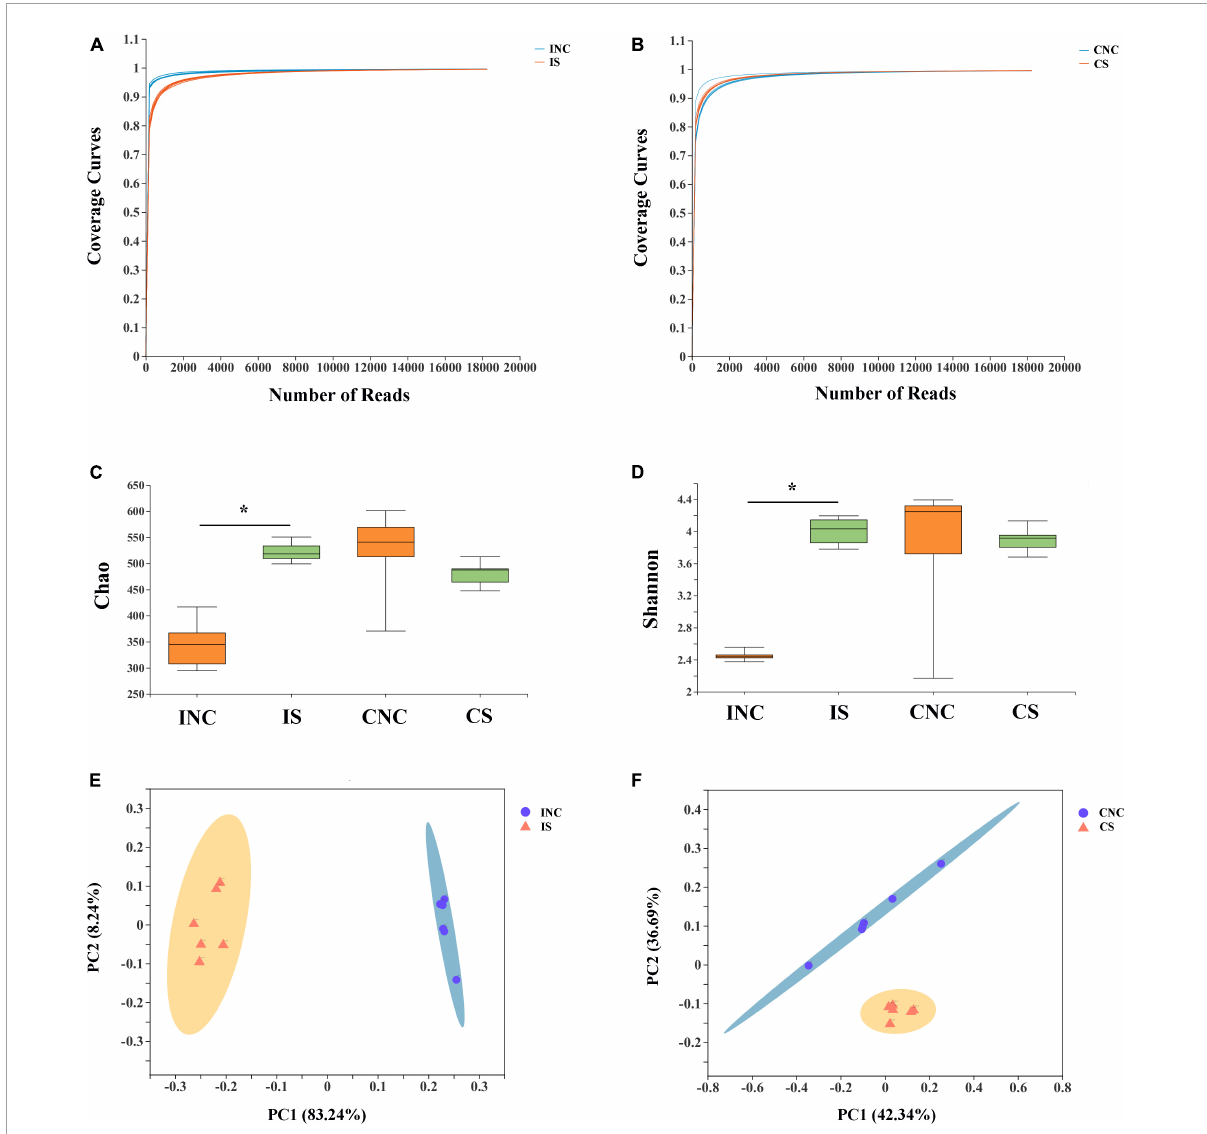
FIGURE3 Alpha diversity and PCoA of bacterial communities between control and 0.2% sodium butyrate treatments in the ileum and the colon from weaned piglets. Sequencing coverage curves of (A) negative control (INC) and basal diet with 0.2% sodium butyrate (IS) from the ileum and (B) negative control (CNC) and basal diet with 0.2% sodium butyrate (CS) from the colon. (C) Chao index of the bacterial community and (D) Shannon index of the bacterial community in four groups. The PCoA analyses of bacterial communities between the control and sodium butyrate treatment group from (E) ileum and (F) colon. The results were analyzed by Wilcoxon rank-sum test, and * P <